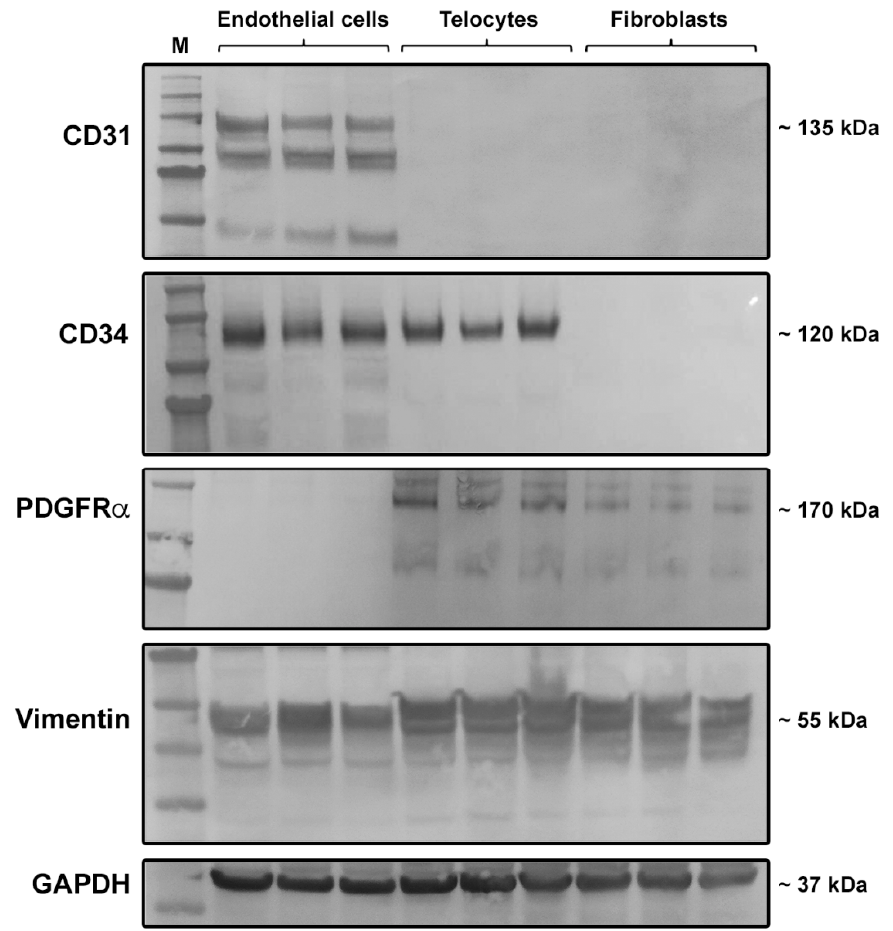
Figure 5. Western blotting analysis of CD31, CD34, platelet-derived growth factor receptor (PDGFR) α , and vimentin protein expression in CD31 + (endothelial cells), CD31 − / CD34 + (telocytes), and CD31 − / CD34 − (fibroblasts) immunomagnetically selected cells. Protein lysates of the three different immunomagnetically purified cell populations were assayed for the expression of CD31, CD34, PDGFR α , and vimentin. Representative immunoblots are shown. Glyceraldehyde 3-phosphate dehydrogenase (GAPDH) was measured as a loading control. Molecular weight values (kDa) are indicated on the right. M—molecular weight marker.